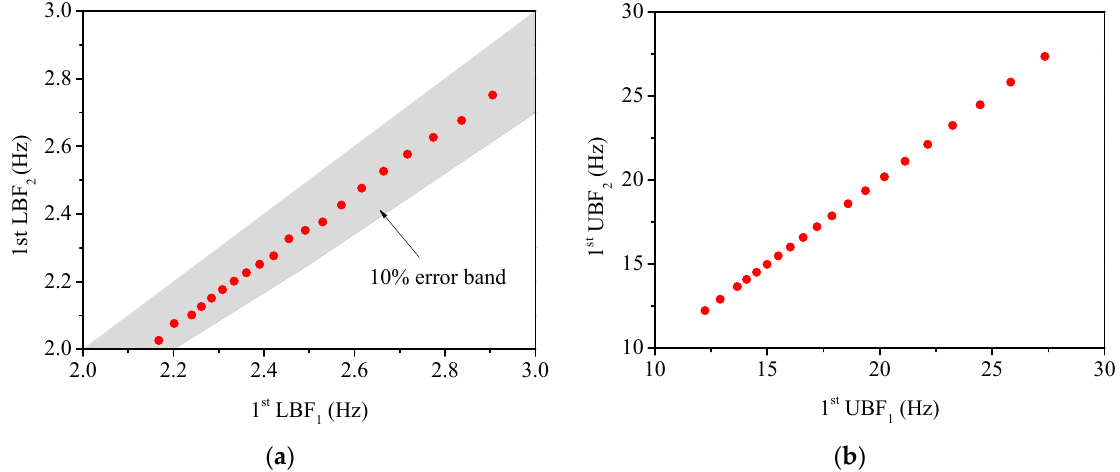
Figure 8. ( a ) LBF and ( b ) UBF of the first CAZ and those of the frequency range of negative FRFs.